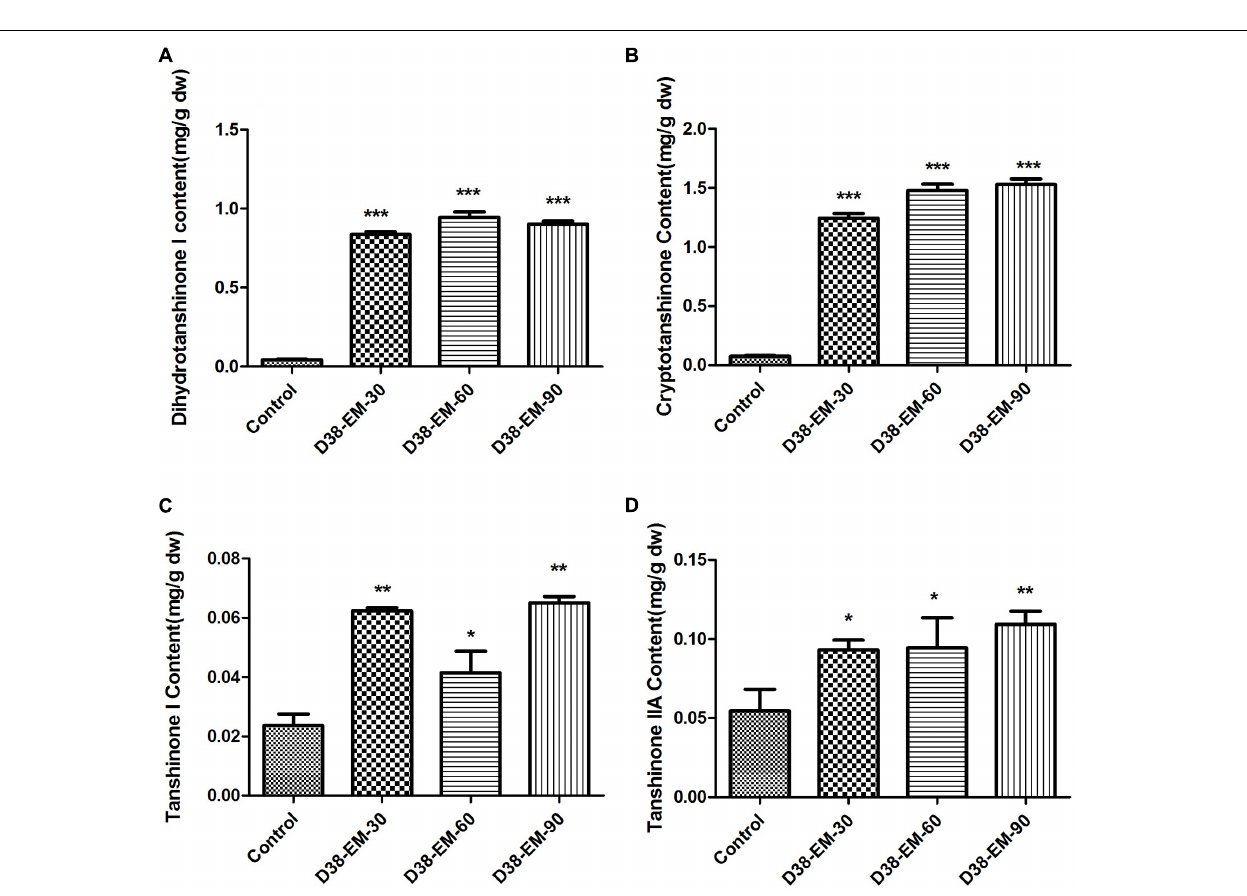
FIGURE 5 | Effects of the extract from D38 mycelium (EM) on the contents of tanshinones in S. miltiorrhiza hairy roots. (A) Dihydrotanshinone I content; (B) Cryptotanshinone content; (C) Tanshinone I content; (D) Tanshinone IIA content. Values are presented as means ± SD, n = 3. ∗ p < 0.05; ∗∗ p < 0.01; ∗∗∗ p < 0.001 versus the control